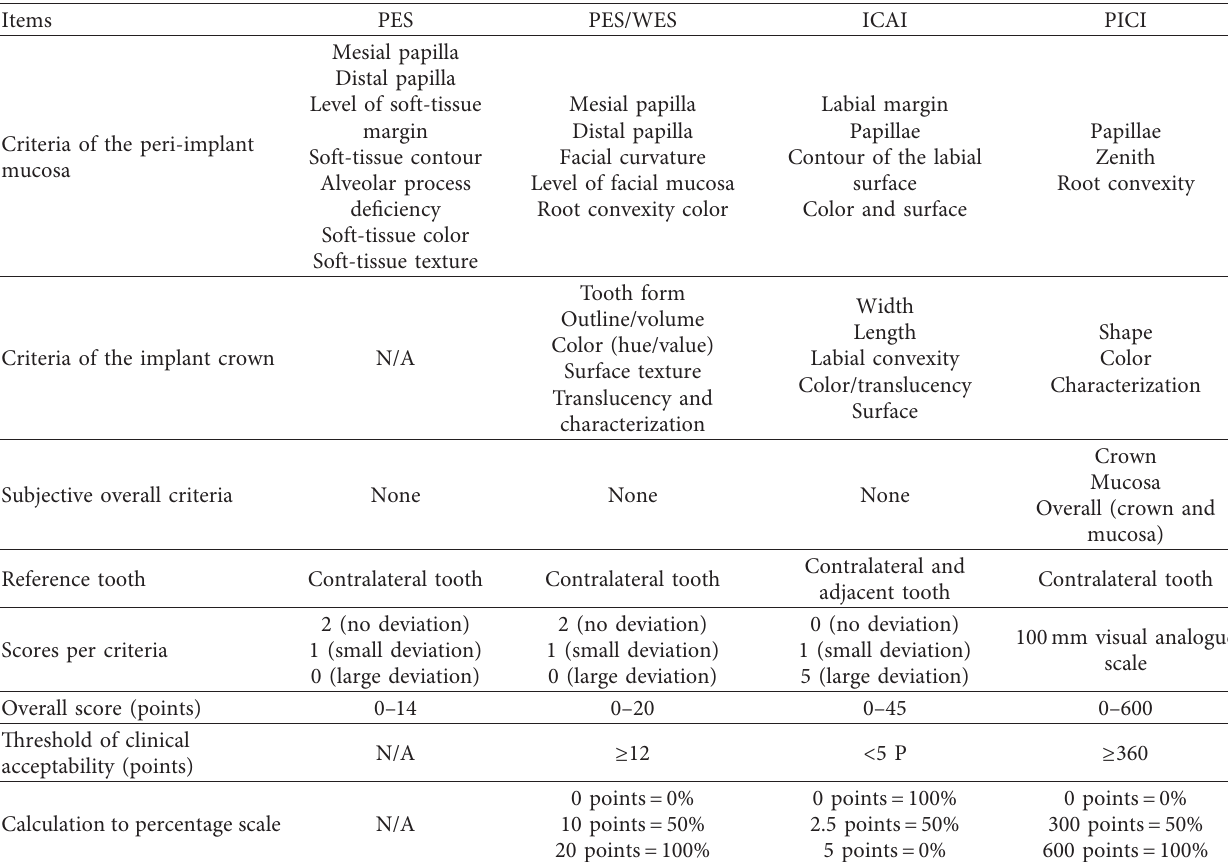
Table 1: Criteria of the commonly used aesthetic indices and calculation of relative